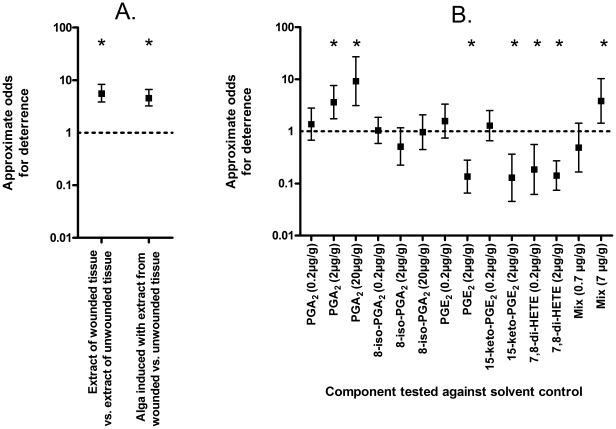
Feeding preference of Idotea baltica.Odds ω for the relative deterrence of the herbivore by artificial diets containing either algal extracts or biomass (A) or isolated eicosanoids (B) are given. Means±95 % confidence intervals are given, asterisks indicate odds that are significantly above or below 1 (Fisher's exact test, p<0.05). A: extract from mechanically wounded algae was tested relative to controls containing extract from intact algae and tissue of algae induced with extract from mechanically wounded algae was tested relative to tissue of control algae that were treated with extract from intact algae. B: five different eicosanoids were tested relative to solvent controls, either isolated or in combination (PGA2:PGE2:15-keto-PGE2:7,8-de-HETE in a ratio of 1∶1∶1∶0.5).